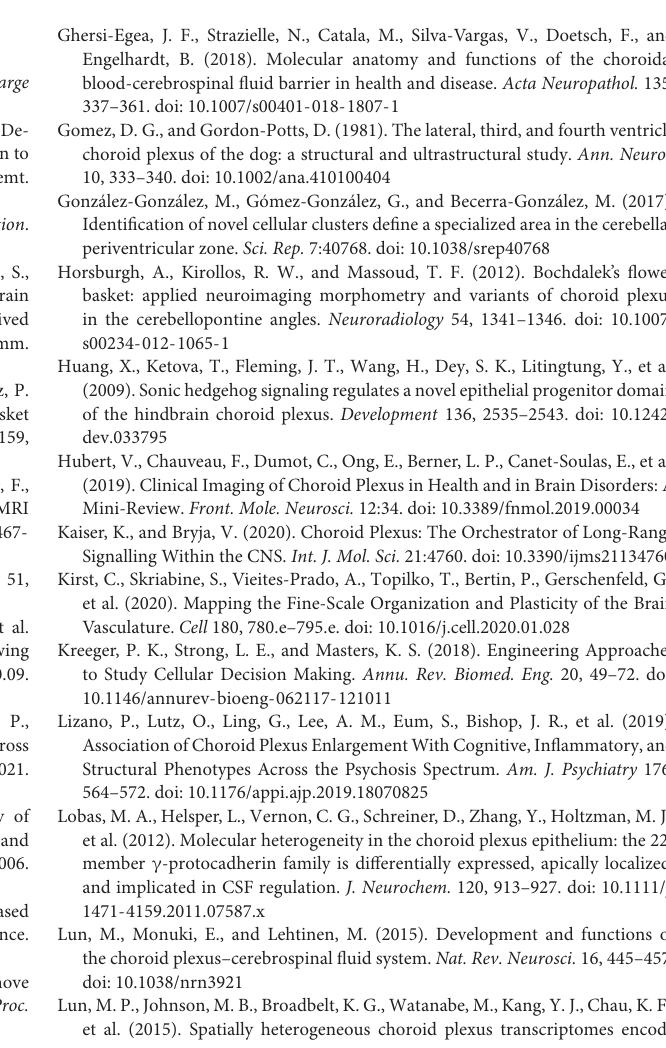
Supplementary Figure 1 | (A) Schema of the CP as in Figure 1A , with indications of arterial points of entry. Symbols and colors indicate samples. (B) Schema of the CP as in Figure 1A , with indications of venous points of entry. Symbols and colors indicate samples. Supplementary Video 1 | Z-stack progression of light-sheet 3D dataset of the whole-mount brain-bone preparation of Figure 2A , showing the extent and association of the CP (highlighted in red). Scale bar: 2 mm. Supplementary Video 2 | (A) 360 ◦ rotation on y -axis of reconstruction shown in Figure 8A1 . (B) 360 ◦ rotation on y -axis of reconstruction shown in Figure 8A2 . (C) 360 ◦ rotation on y -axis of reconstruction shown in Figure 8A3 . (D) 360 ◦ rotation on y -axis of reconstruction shown in Figure 8A4 . Supplementary Video 3 | Z-stack progression of light-sheet 3D dataset of the region shown in Figure 9B . Scale bar: 200 µ